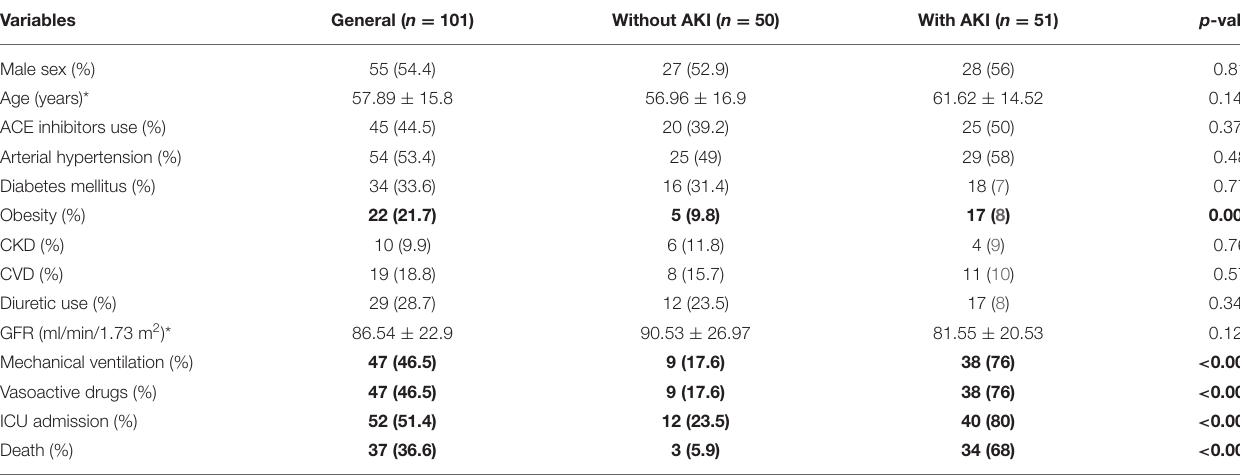
TABLE 1 | Clinical and laboratory characteristics of hospitalized patients regarding the presence or absence of AKI. Variables